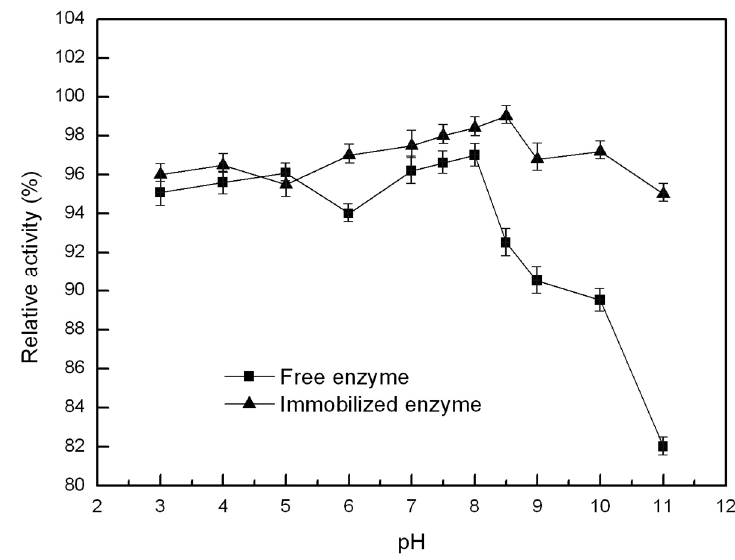
Figure 8. The pH stability; the activities of the untreated enzyme were taken as 100%.